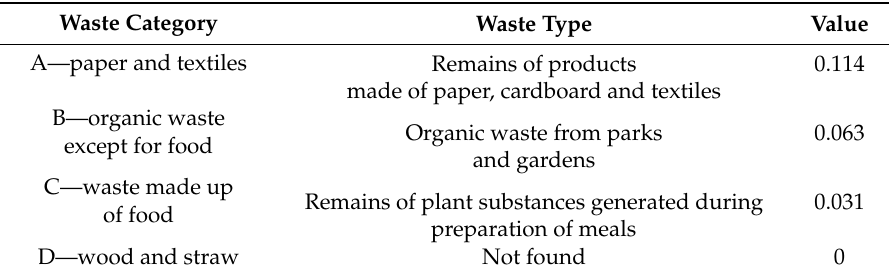
Table 3. Percentage share of individual fractions of biodegradable waste.